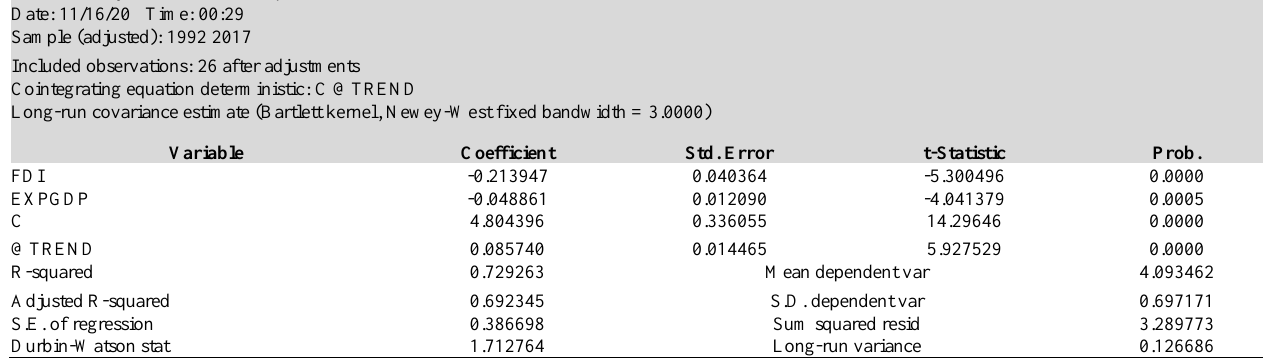
poverty equation estimate proxied by the unemployment